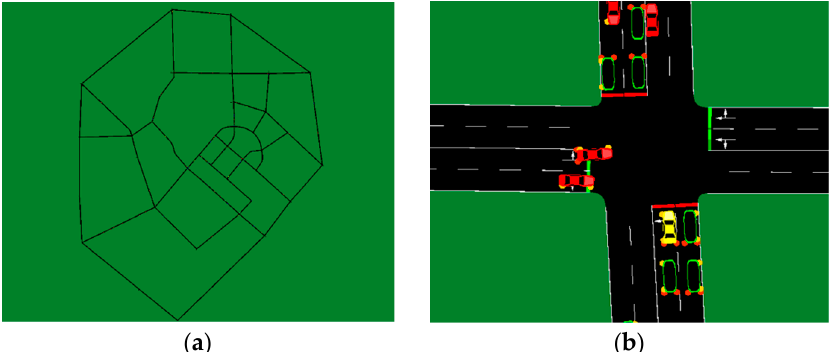
Figure 3. Traffic network model based on the simulation of urban mobility (SUMO) software: ( a ) map of the 20 km 2 area; ( b ) local intersection model.